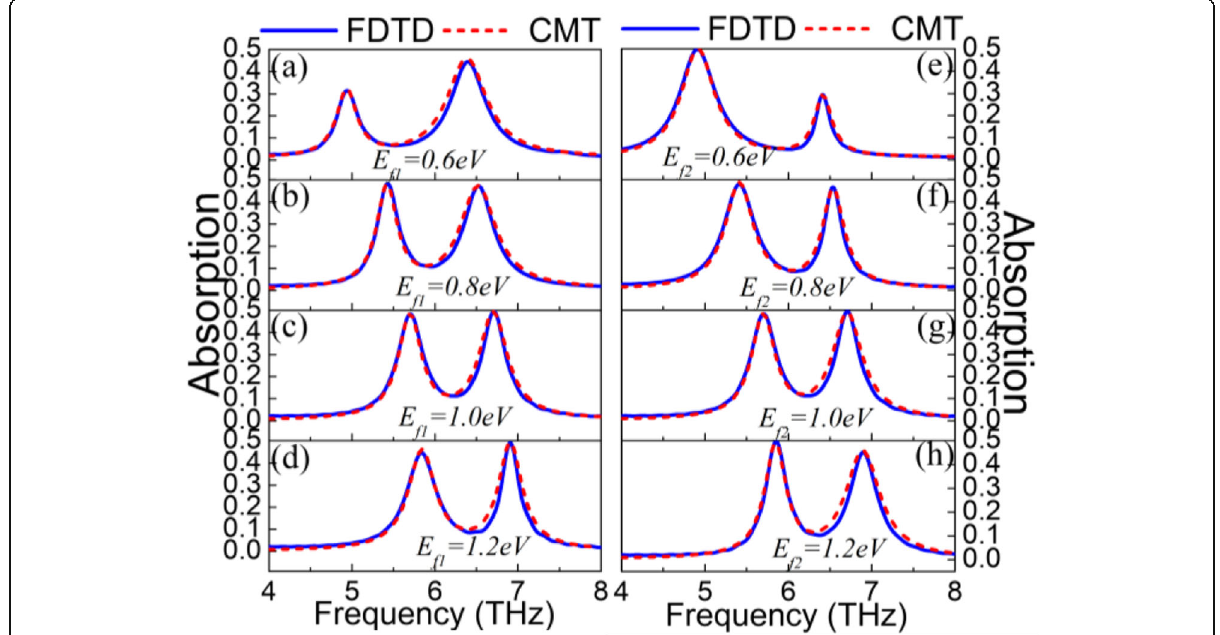
Fig. 4 Absorption spectra of FDTD simulation and CMT fitting ( a – d ) for different E f 1 when E f 2 = 1.0 eV. e – h For different E f 2 when E f 1 = 1.0 eV